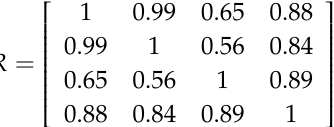
Figure 5. Line chart of gas content after multiplying coefficient.